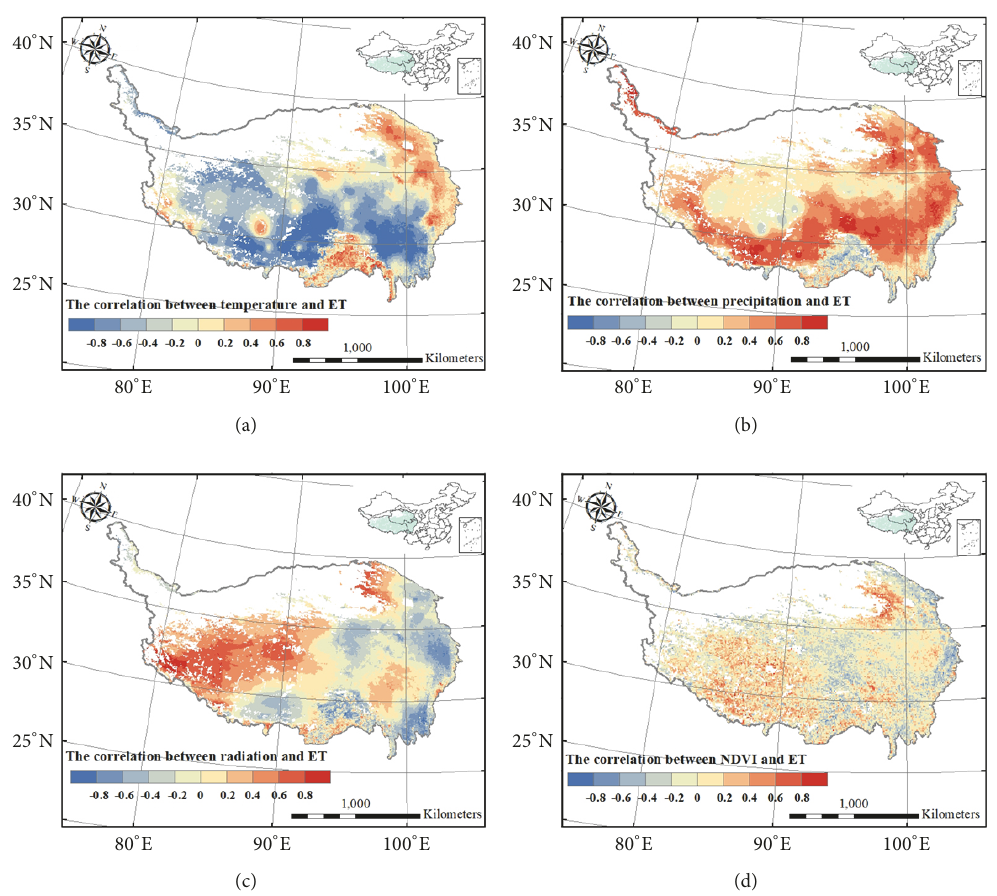
Figure 4: Responses of ET to variation of four environmental factors across the Tibetan Plateau. Graphs (a), (b), (c), and (d) represent the variation with temperature, precipitation, radiation, and NDVI,